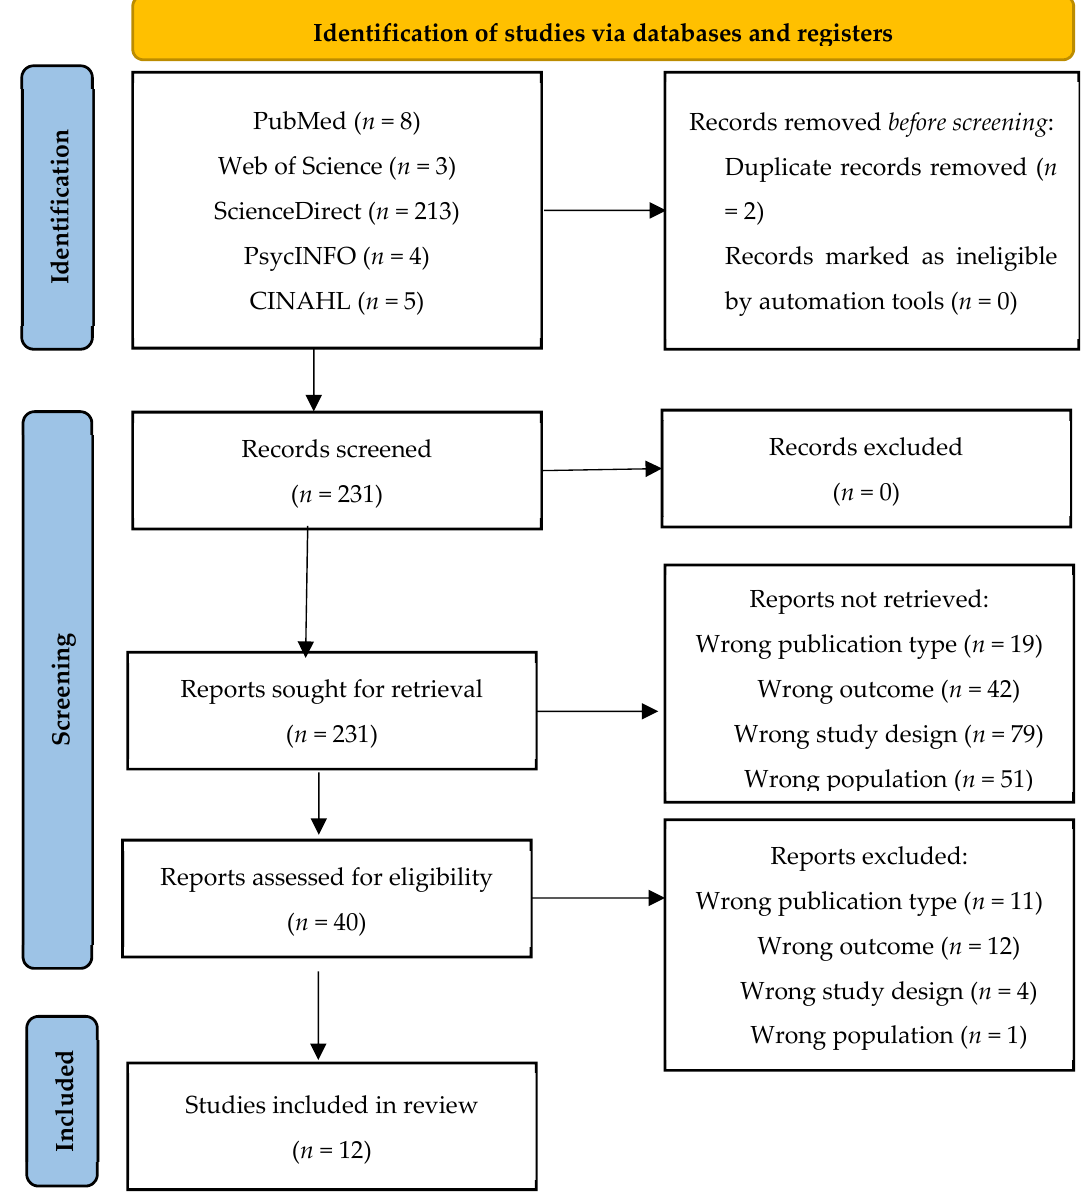
Figure 1. This figure shows the flow diagram utilized for the review, based on the PRISMA model (2020) .